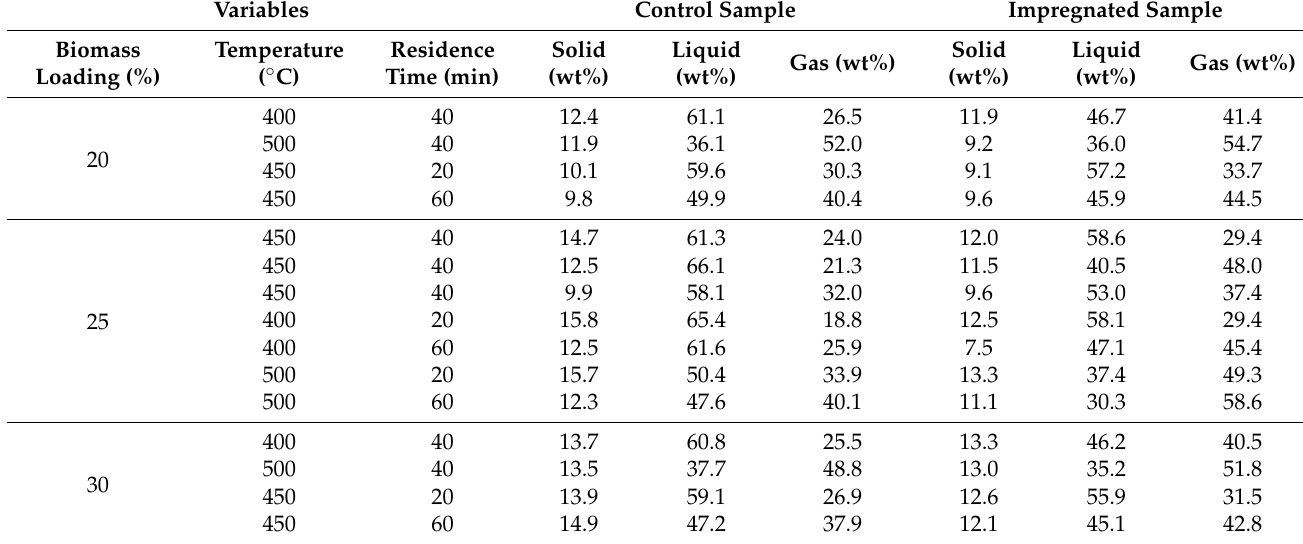
Table 9. Solid, liquid and gas yields from SCWG of control and impregnated